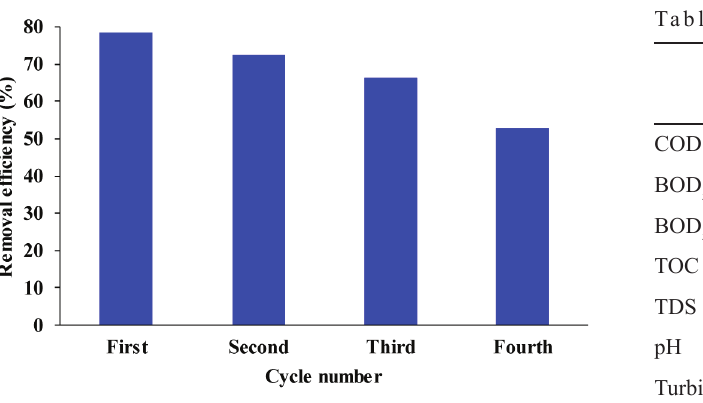
/AC nanocomposite 2